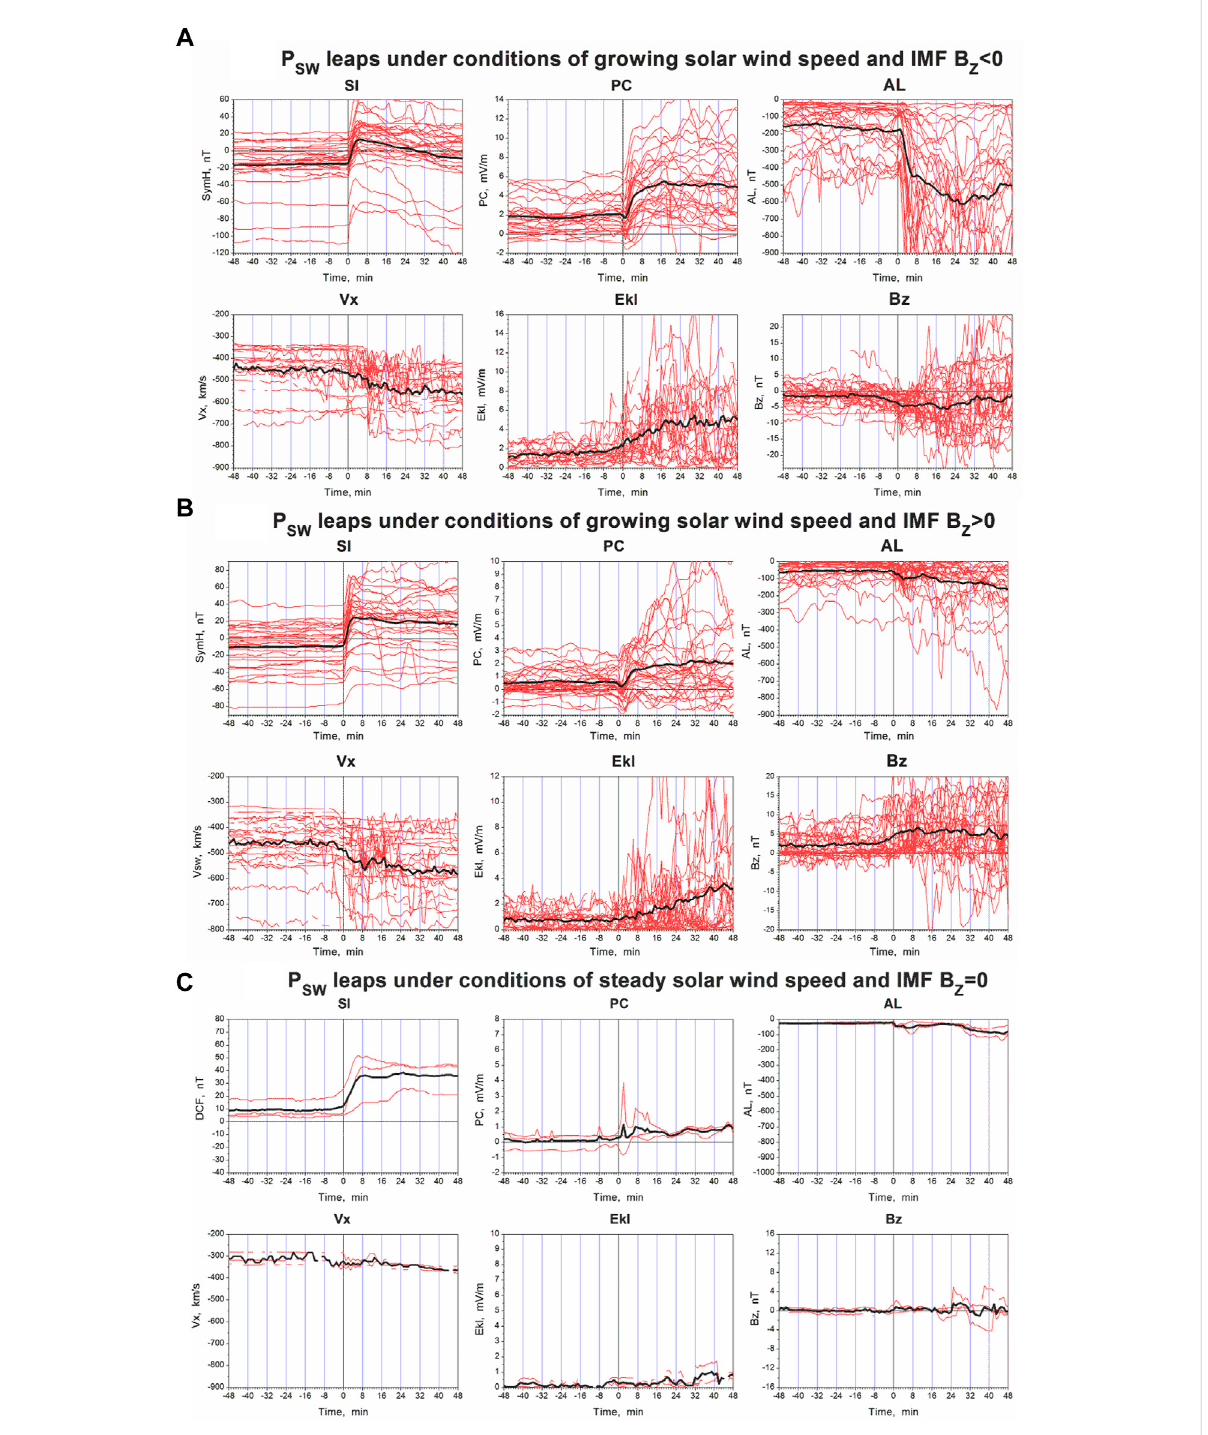
FIGURE 13 Time evolution of the actual ground-based SI events (identi fi ed with the Pdyn leaps), solar wind parameters Vsw, BZ, EKL and PC, AL indices under different conditions: (A) growing solar wind speed and negative IMF BZ values, (B) growing solar wind speed and positive IMF BZ values, (C) steady solar wind speed and BZ = 0 (Troshichev and Sormakov,